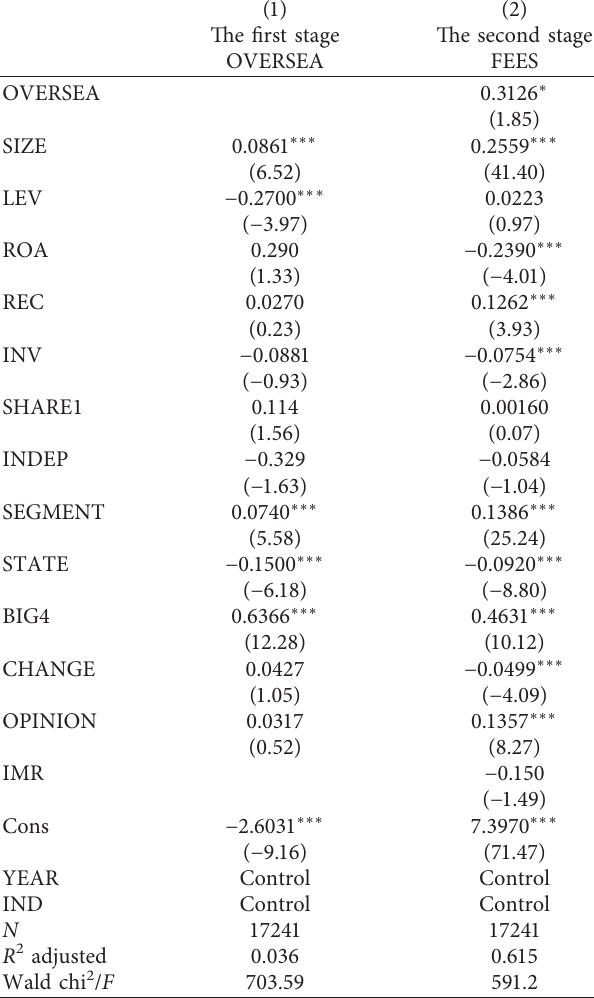
Table 13: Two-stage